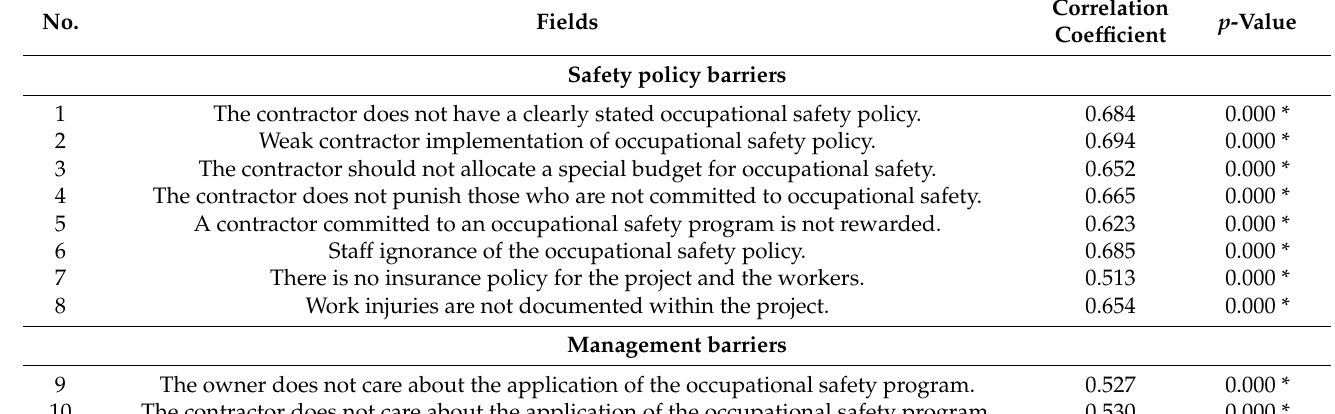
Correlation p -Value Coefficient